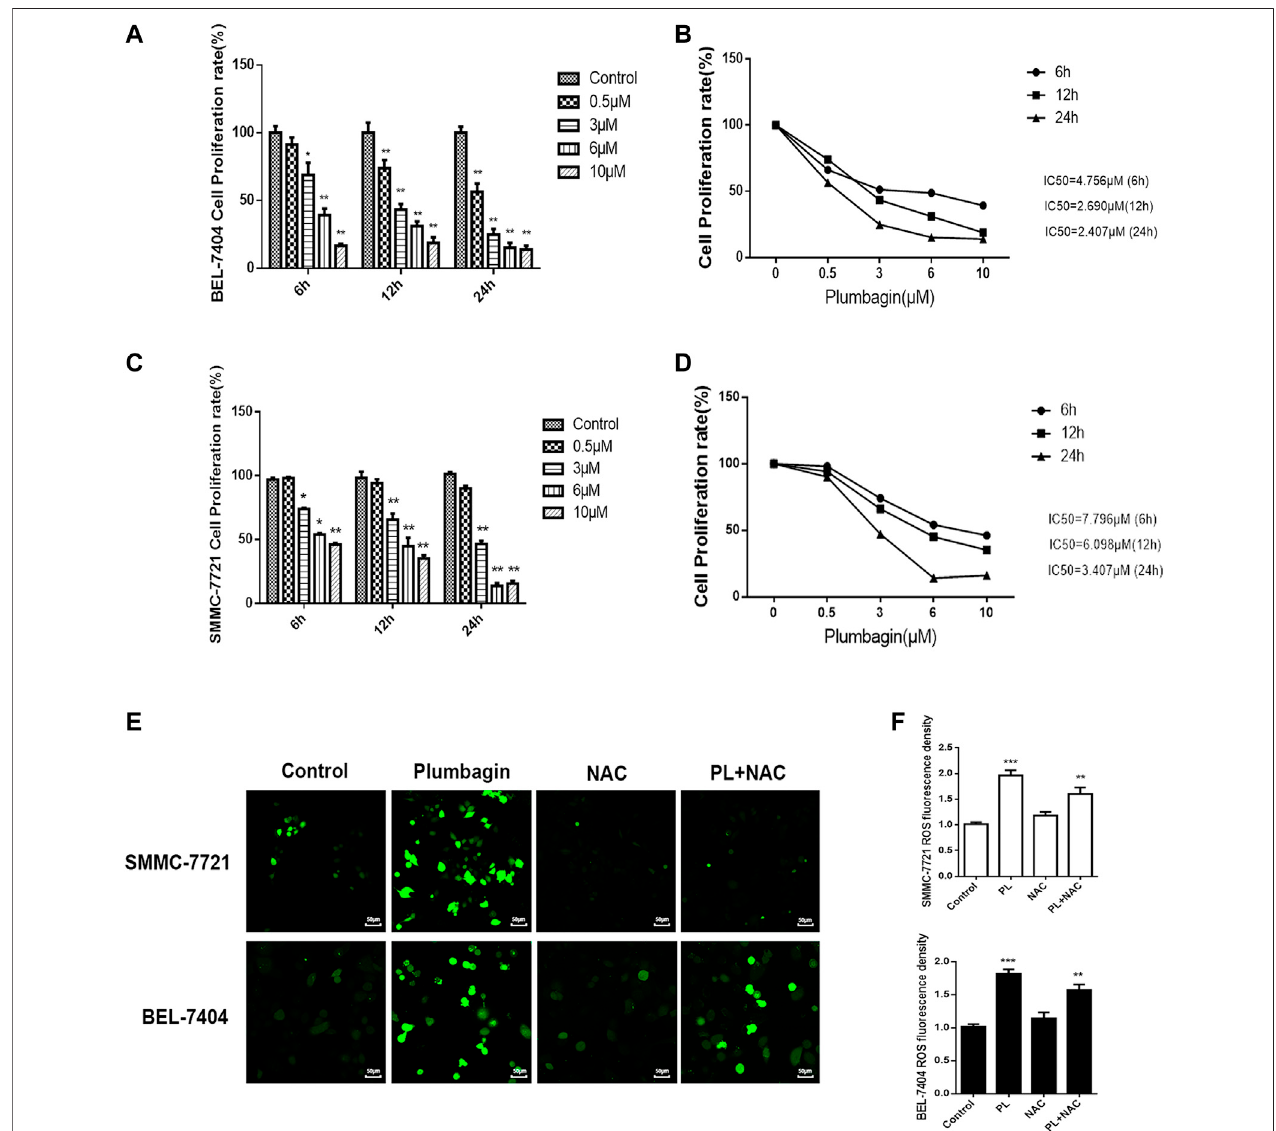
FIGURE 4| (A) CellviabilityofBEL-7404cellstreatedwithvariousconcentrationsofPL(0.5,3,6,and10 μ M)for6,12or24 h*; p < 0.05,**; p < 0.01***; p < 0.001,compared withthe0 μ Mgroup. (B) The50%inhibitoryconcentrations(IC50)ofBEL-7404cellswere4.756 μ Mat6 h,2.690 μ Mat12 h,and2.407 μ Mat24 h. (C) CellviabilityofSMMC-7721 cells treated with various concentrations of PL (0.5, 3, 6, and 10 μ M) for 6, 12 or 24 h; p < 0.05, **; p < 0.01 ***; p < 0.001, compared with the 0 μ M group. (D) The 50% inhibitory concentrations(IC50)ofSMMC-7721cellswere7.796 μ Mat6 h,6.098 μ Mat12 h,and3.407 μ Mat24 h. (E) TheproductionofROSwasmeasuredbyDCFH-DAtoassess the level of oxidative stress. SMMC-7721 and BEL-7404 cells were pretreated with 10 mM NAC for 30 min and were then treated with 5 μ M PL for 24 h, and fl uorescence was detectedbyconfocal fl uorescencemicroscopy.Scalebar,50 μ m. (F) Forstatisticalanalysis,themeanDCFH-DA fl uorescenceintensity(representingcellularROSlevel)wasmeasured from 9 random fi elds for each culture. All values represent the mean ± SEM of three independent experiments. * p < 0.05, ** p < 0.01 vs. normal control group, respectively.